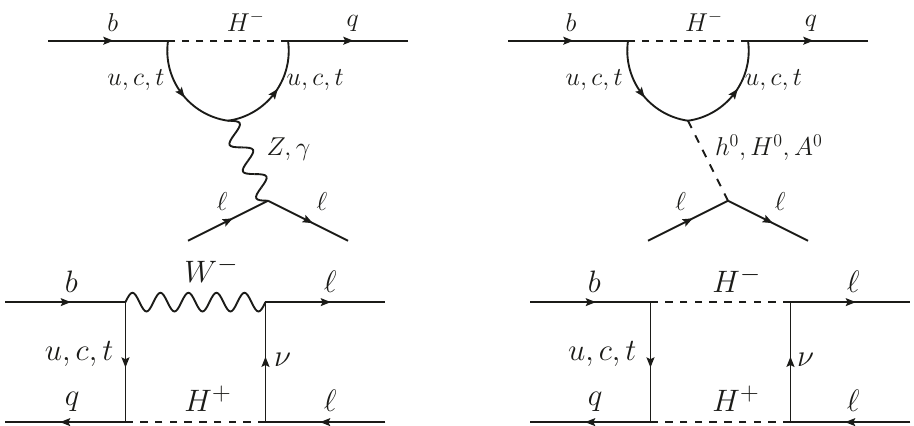
Figure 9. Example of diagrams (penguins and boxes) describing the b → q‘ + ‘ − transitions in the 2HDM.